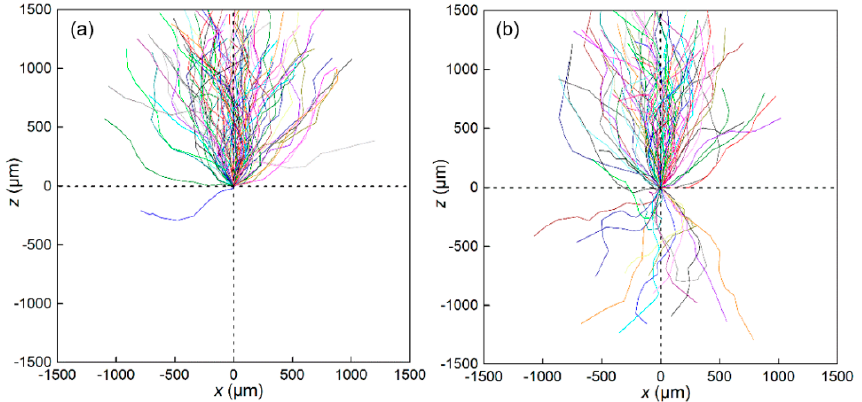
Figure 9. Swimming trajectories (100 tracks) of H. akashiwo cells in x-z plane: ( a ) t = 20 min, and ( b ) t = 55 min.